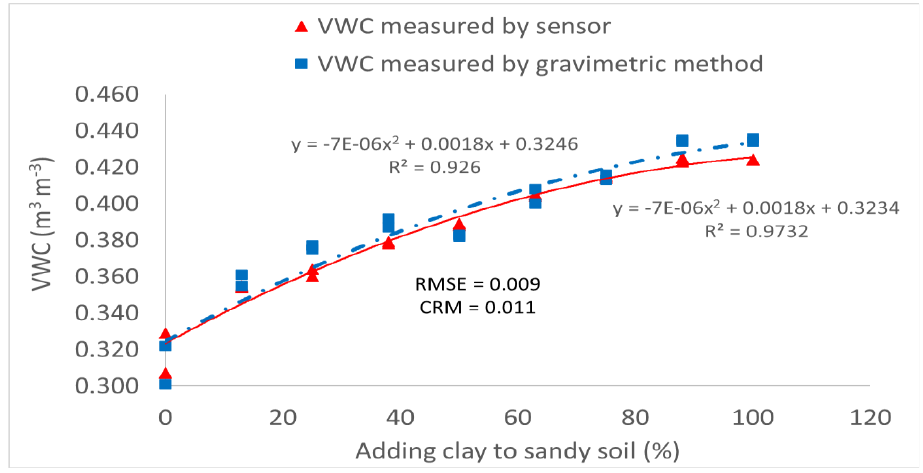
Figure 7. Influence of soil texture on sensor measurements.